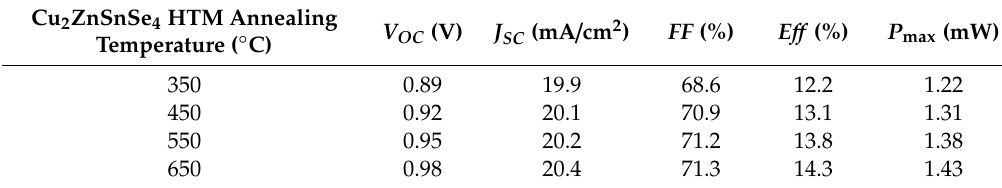
Figure 9. The J – V curves of Ag / ZnS / MAPbI 3 / Cu 2 ZnSnSe 4 / Mo / FTO nanostructured solar cells, under 100 mW / cm 2 illumination. The Cu 2 ZnSnSe 4 HTM has been thermally treated at the various annealing temperature 350–650 ◦ C. Table 2. The PV characteristic parameters of the Ag / ZnS / MAPbI 3 / Cu 2 ZnSnSe 4 / Mo / FTO nanostructured solar cells.